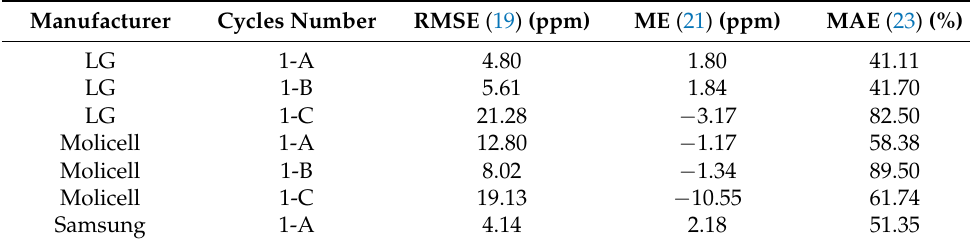
Table 7. Error comparison obtained with the new cell. Resistance R 0 error estimation.